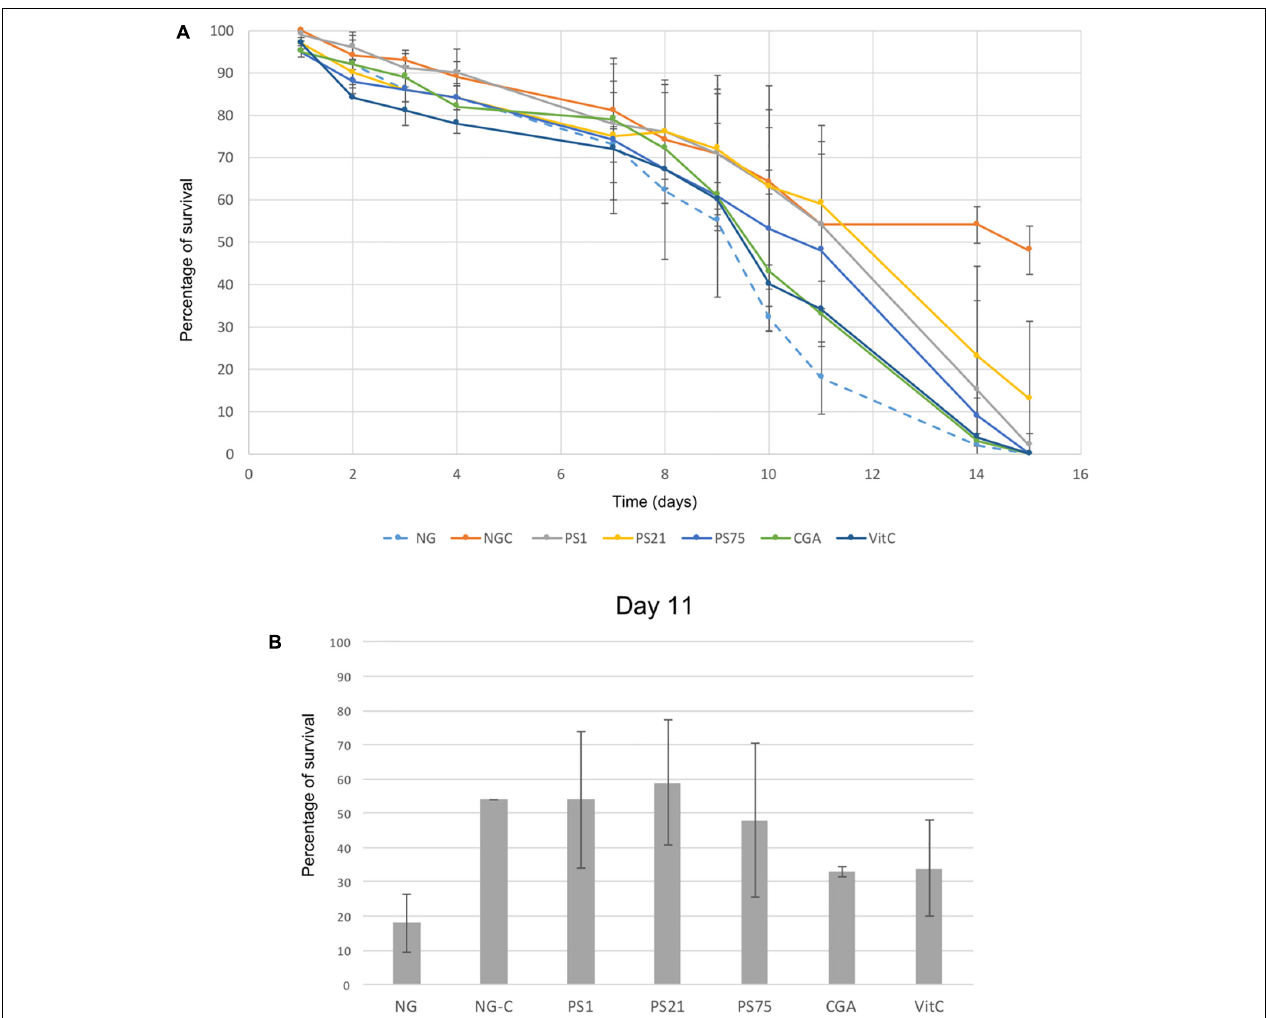
FIGURE 2 | UV-light protection assay. Error bars indicate standard deviation. (A) Y-axis indicates percentage of survival of C. elegans irradiated with UV-light for 45 s every day over a period of 15 days (X-axis). NG-C indicates the non-irradiated controls: the basal survival rate of the worms over the 15-day period. NG refers to the negative control: worms incubated in NGM with no supplements and irradiated during the 15 days. CGA and VitC are two positive controls: worms incubated with antioxidant compounds (chlorogenic acid and vitamin C) and irradiated during 15 days. Finally, PS1, PS21, and PS75 ( Planomicrobium sp., Rhodobacter sp., and Bacillus sp., respectively) indicate worms incubated with pigmented solar panel isolates and irradiated over the 15-day period in order to test the protective effect of these isolates against UV-light. (B) Results at day 11, in which the largest differences between the negative control and the worms fed with the pigmented isolates were